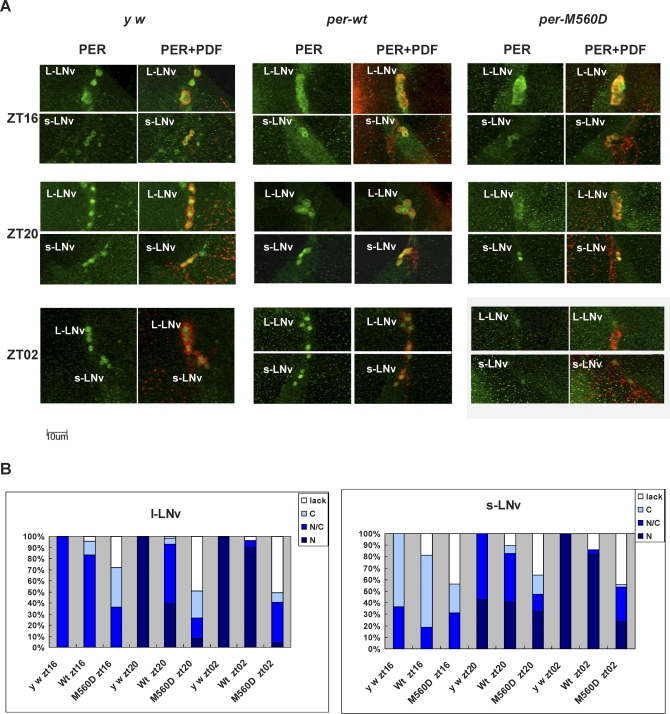
The M560D Mutation Interferes with Nuclear Translocation of PER(A)Whole mounted brains prepared from control and M560D flies were prepared from flies collected at the indicated ZT times at 25 °C. Anti-PER (green) and anti-PDF (red) stainings (Materials and Methods) revealed normal cytoplasmic and nuclear localization in the large and small LNv's of nontransgenic control flies (left panel) as well as per01 per-wild-type transgenics (middle panel). The M560D mutant exhibits overall less PER-positive LNs, and in the remaining neurons nuclear translocation is severely impaired (see Results for details).(B) Quantification of staining results separate for small and large LNvs (see Materials and Methods for details). Lack, neurons without any detectable PER staining; C, N, neurons with predominantly cytoplasmic or nuclear signal, respectively; N/C, equal staining intensity in both compartments. The transgenic lines used for this analysis were the same than the ones for the CoIP analysis. For each genotype the following numbers of brain hemispheres (n) were analyzed: y w (ZT16, n = 8; ZT20, n = 7; ZT2, n = 5; M560D [ZT16, n = 13; ZT20, n = 15; ZT2, n = 12), per wild-type (ZT16, n = 12; ZT20, n = 14; ZT2, n = 13).